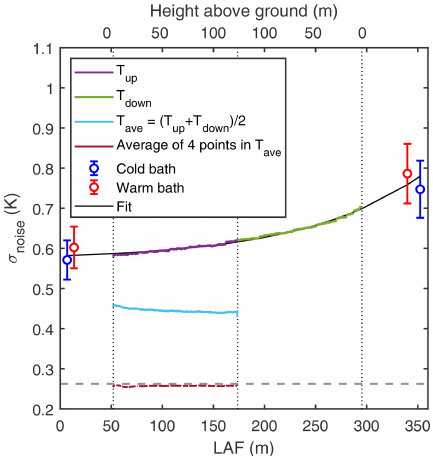
Figure 2. Increase in noise at step losses (i.e. sudden decreases in P s and P as ) along the cable versus step loss − 3 LAF ,